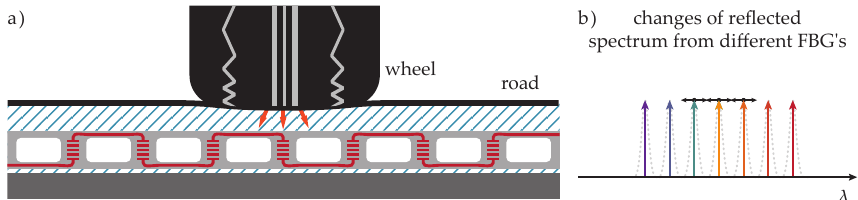
Figure 2. ( a ) Wheel pressure is applied to vertically oriented FGB sensors; ( b ) reflected optical spectrum shift is given by pressure change (every FBG reflects light on the other’scentral wavelength in idle status—the FBG’s position is also known).